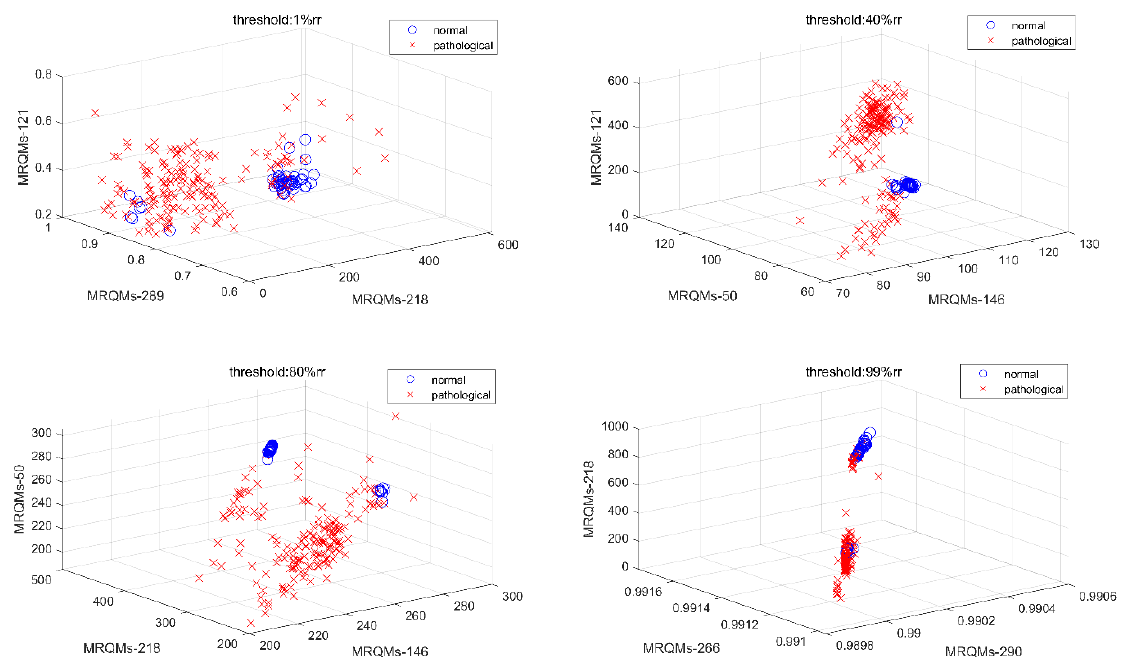
Figure 4. Three-dimensional scatter plots of MRQMs.